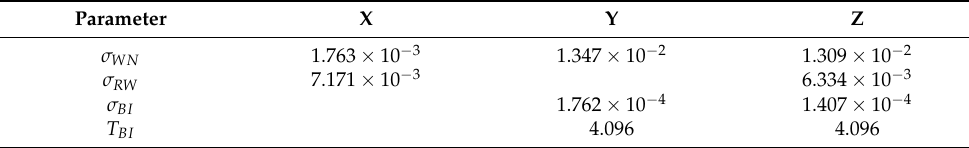
Figure 9. A GMWM log – log plot of the three-axis gyroscope ( left column ) and an AV log – log plot of the three-axis gyroscope ( right column ). The red dashed lines are auxiliary lines to help identify linear regions. Table 2. The parameter estimation results of AV-based method.